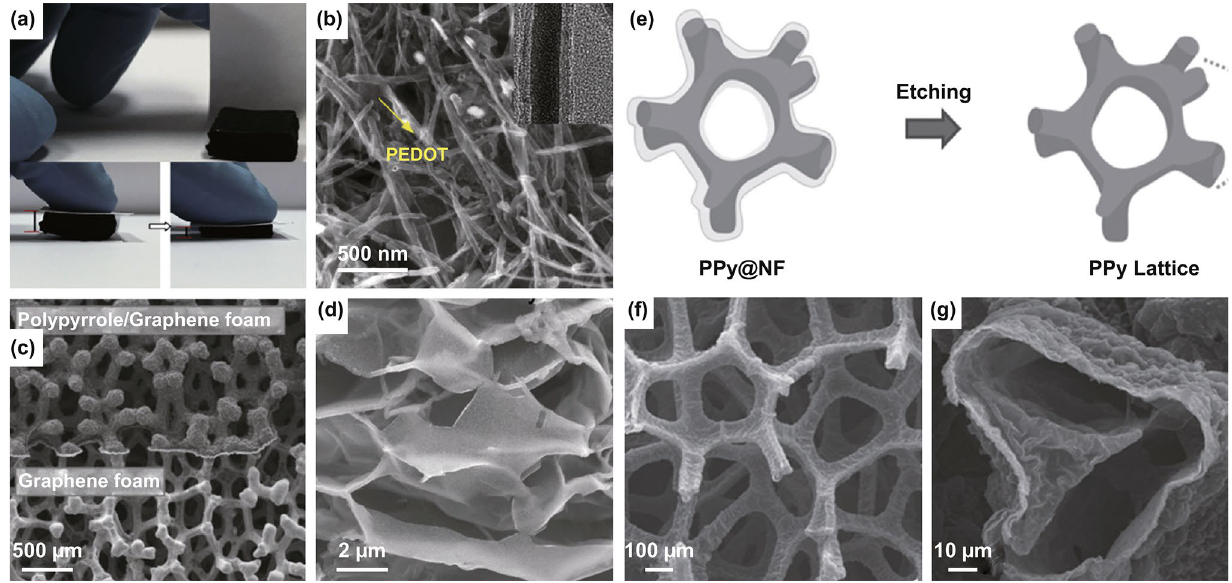
Fig. 16 a Photographs and b SEM and TEM (inset) images of a compressible, PEDOT‑coated carbon nanotube sponge. c SEM image of PPy‑ coated graphene (top) and bare graphene (bottom) foams. d PPy film deposited on electrochemically exfoliated graphite foil. e Scheme of the fabrication process of 3D PPy foam. f , g SEM images of 3D PPy foam at different magnifications. Adapted from a , b Ref. [163], c Ref. [164], d Ref. [26], e – g Ref. [165] with